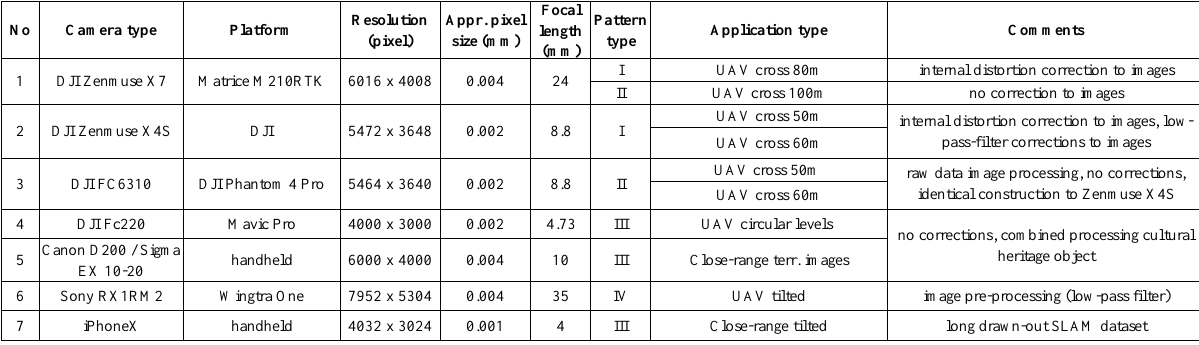
Table 1. Overview of evaluation data sets with different conditions in image processing and application type; all cameras are operated with global shutter, image configurations are given in Figure 2.